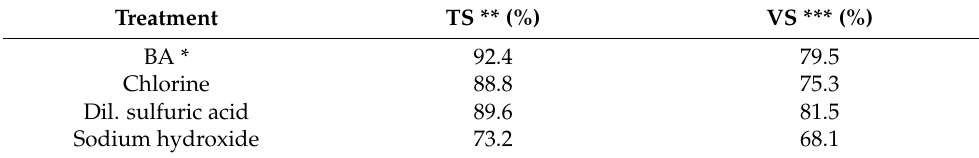
Table 3. Variation of the TS and VS content of GW with different delignification